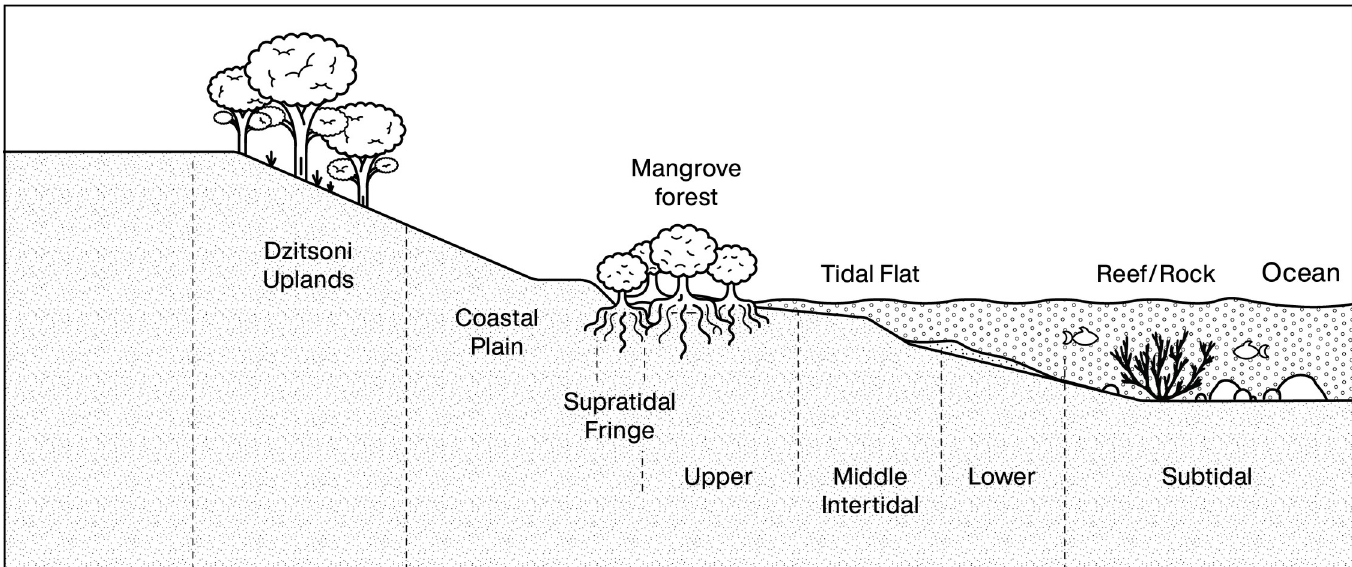
Fig 7. Schematic cross section of habitats on the Kenyan coast from the Dzitsoni Uplands to subtidal reefs. https://doi.org/10.1371/journal.pone.0256761.g007 late Holocene Layers, the Conidae peak sometime between c.48 and 33 kya (Layer 10, 12.6 NISP/m 3 ), with single specimens present in Layer 15 (unmodified Conus cf. geographus ; 62 kya) and Layer 16 (at c. 67 kya). The Cypraeidae/ Volvarina spp. occur within Layers 15 and 11 (62 and 48 kya respectively) but increase to a minor degree from the terminal Pleistocene to peak in the late Holocene in Layer 1 (0.6–6.4 NISP/m 3 ). These trends indicate differential